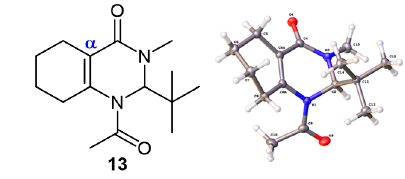
Figure 11 . Structure and X-ray diffraction of hexahidroquinazolinone ( 13 ). Figure 11. Structure and X-ray di ff raction of hexahidroquinazolinone ( 13